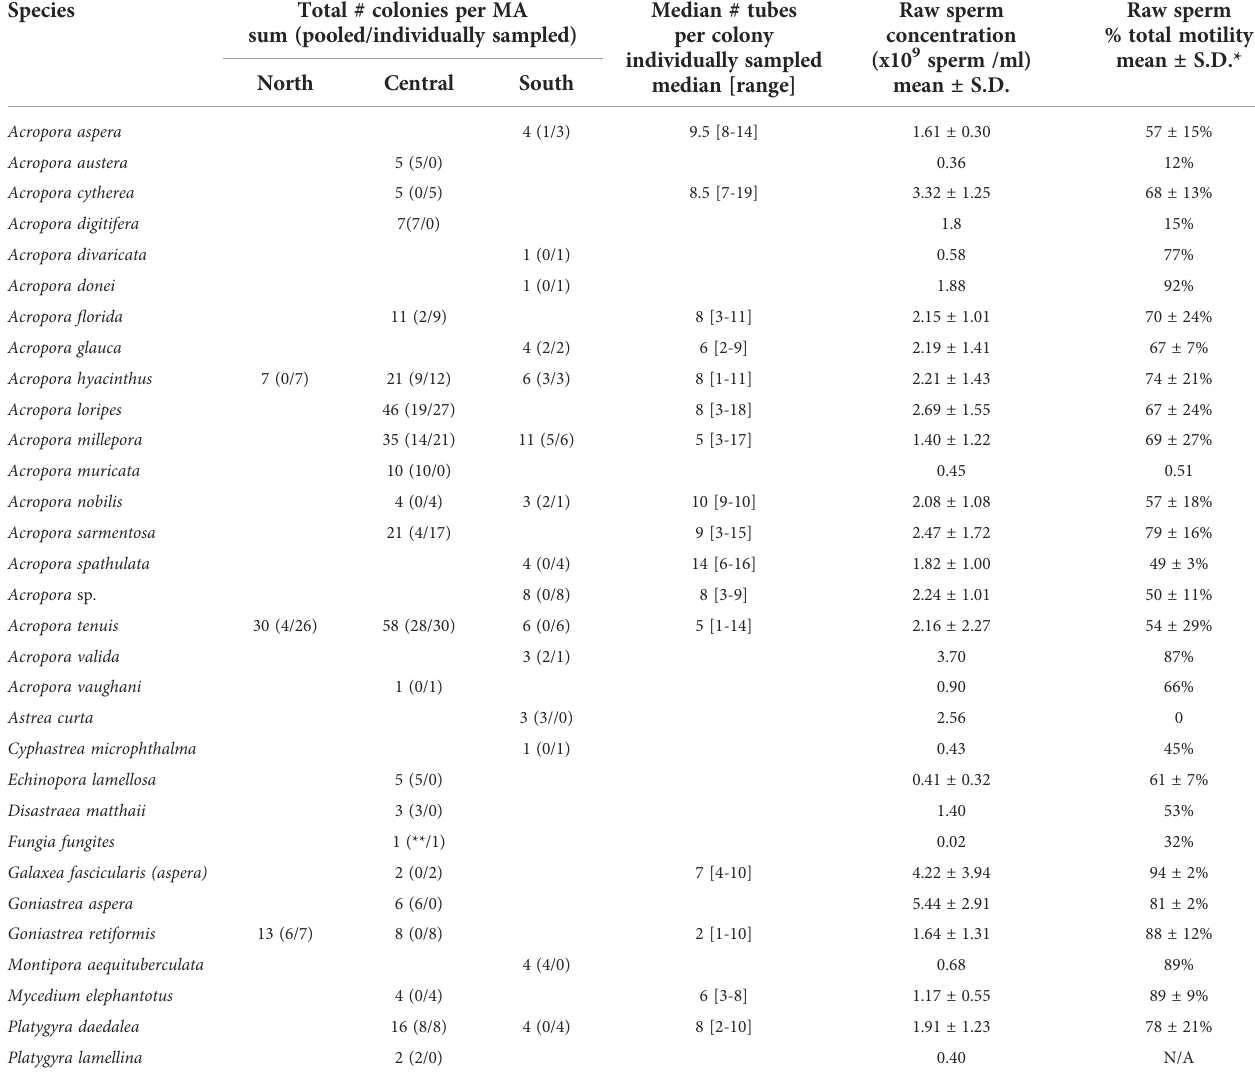
TABLE 1 Summary of sample quantity and type (pooled or individual), sample quality (motility and concentration), and the number and distribution of coral colonies across local management areas (origin) represented in Taronga ’ s CryoDiversity Bank.